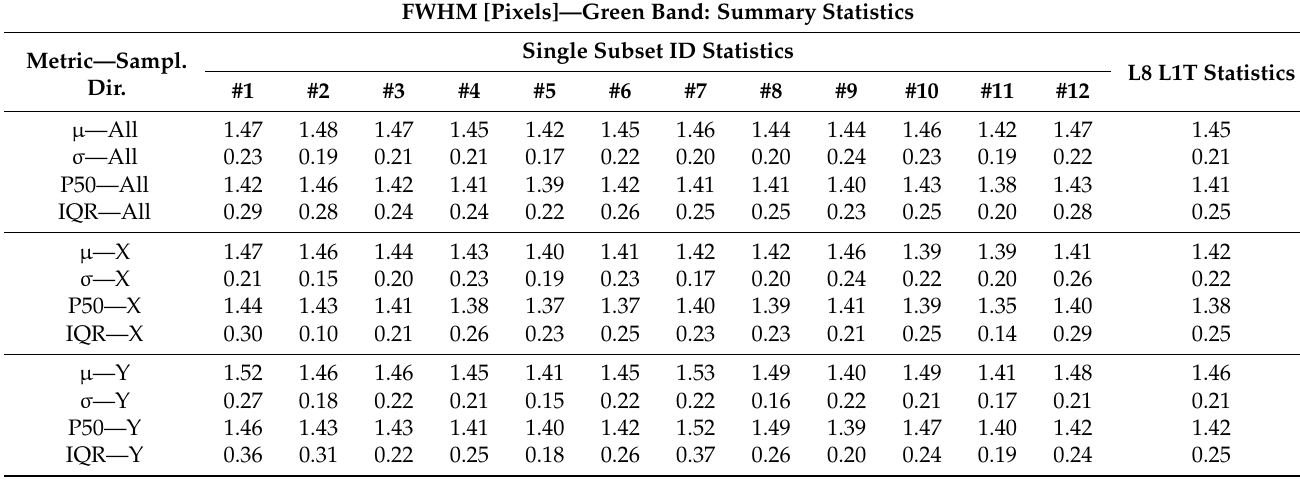
Table 5. SaSbEM validation results for the green